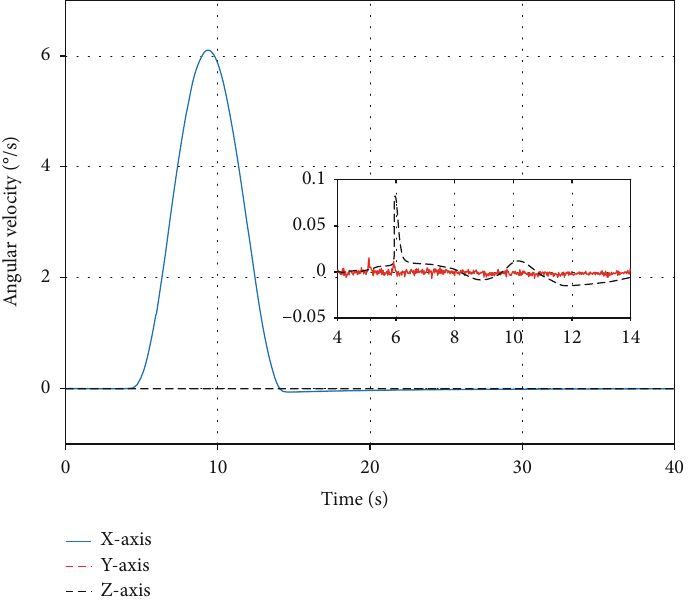
Figure 10: Angular velocity of payload module with compound